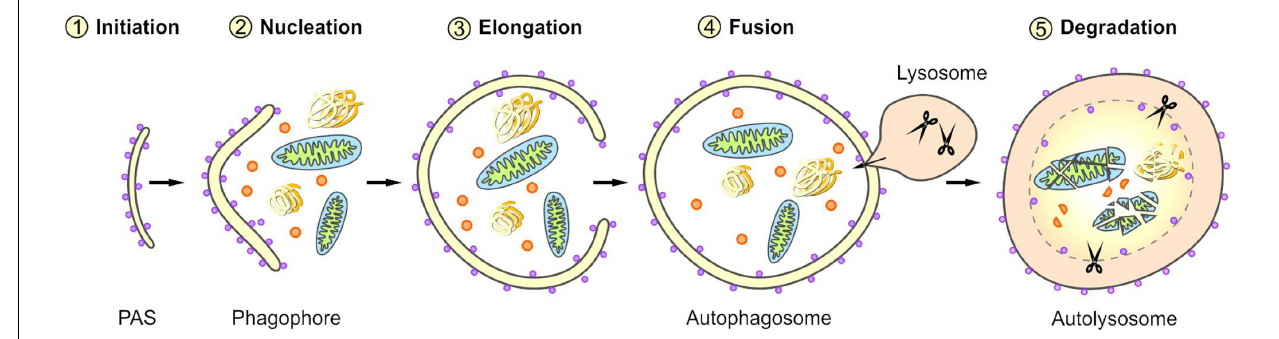
FIGURE 2 | Scheme of selective macroautophagy. Macroautophagy represents a complex multi-step process. After the initiation of macroautophagy (1: Initiation) a phagophore is formed at the phagophore assembly site (PAS) (2: Nucleation). Subsequently, the phagophore expands by recruiting membranes derived from different intracellular sources (3: Elongation) and thereby sequesters the cargo. The closing of the phagophore results in the formation of a mature autophagosome. Following its transport to the lysosome, the autophagosome fuses with the lysosome (4: Fusion), generating an autolysosome. Within the autolysosome, the enclosed material is degraded (5: